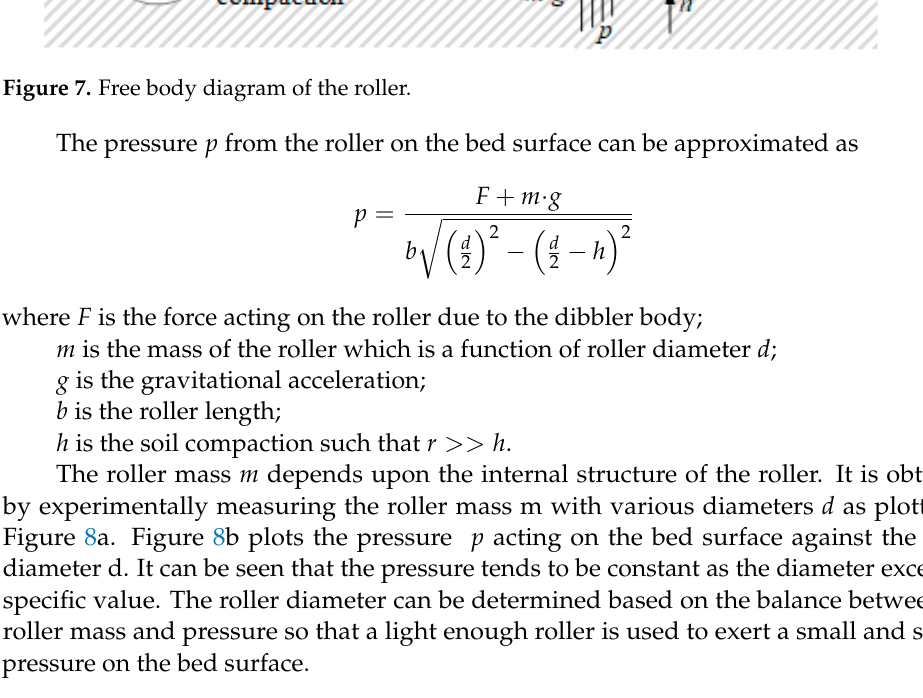
Figure 8a. Figure 8b plots the pressure p acting on the bed surface against the roller diameter d. It can be seen that the pressure tends to be constant as the diameter exceeds a specific value. The roller diameter can be determined based on the balance between the roller mass and pressure so that a light enough roller is used to exert a small and steady pressure on the bed